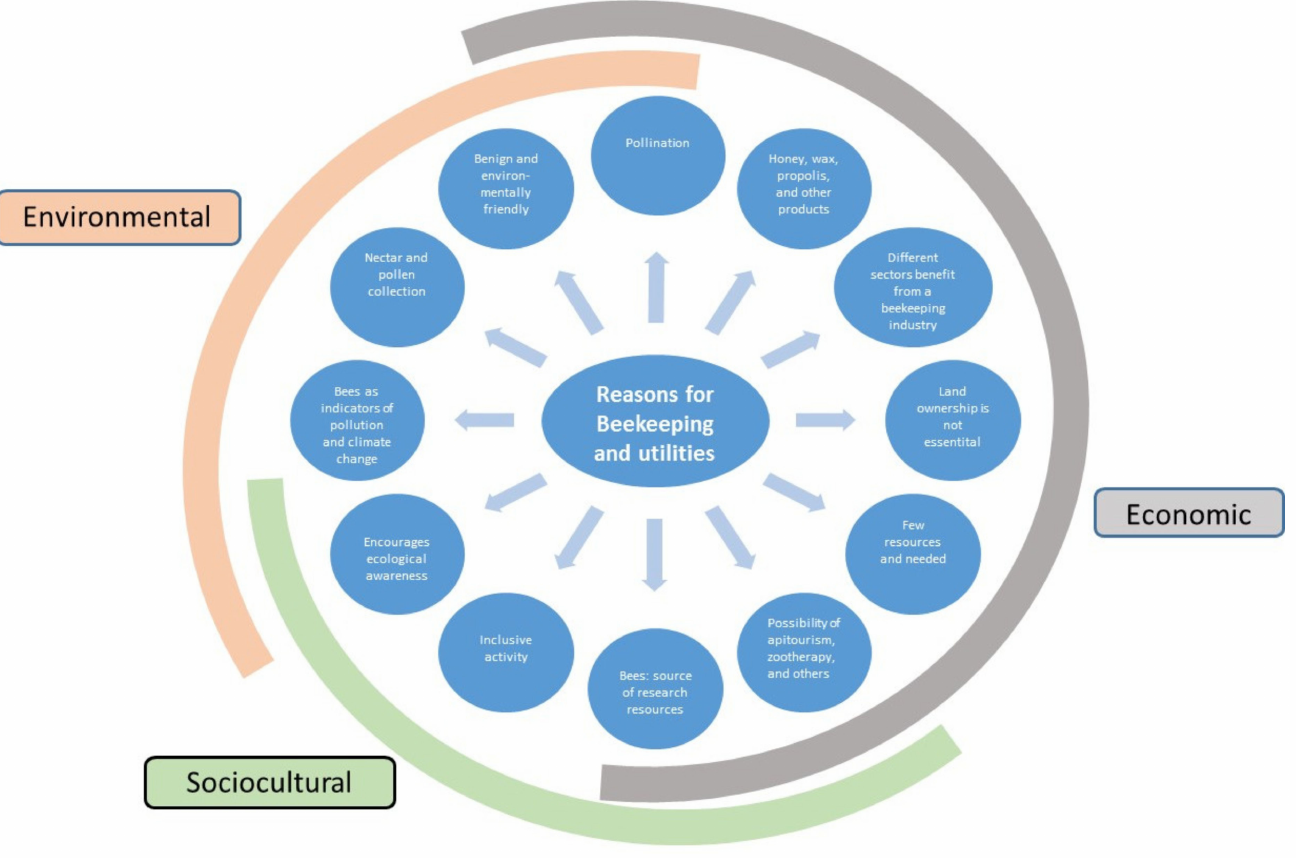
Figure 3. Reasons for beekeeping and utilities. Source: Own elaboration based on Bradbear